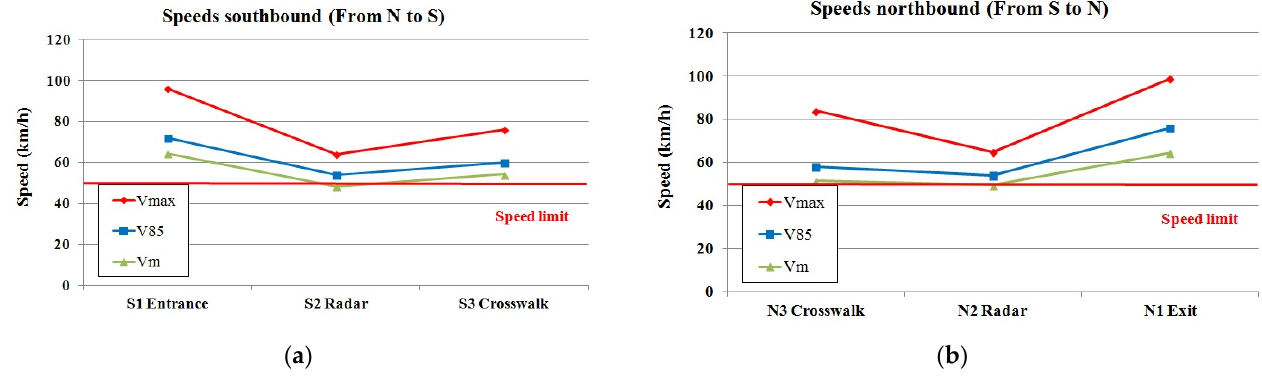
Figure 6. Speed at each controlled point in Chodorówka Nowa (Poland): ( a ) southbound, ( b ) northbound.